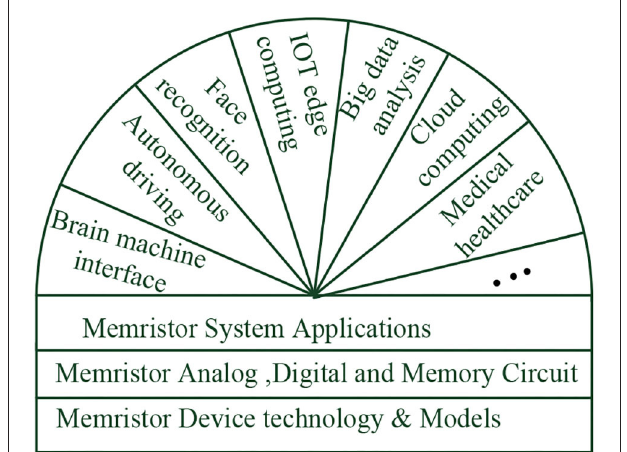
FIGURE 2 | Memristor research and